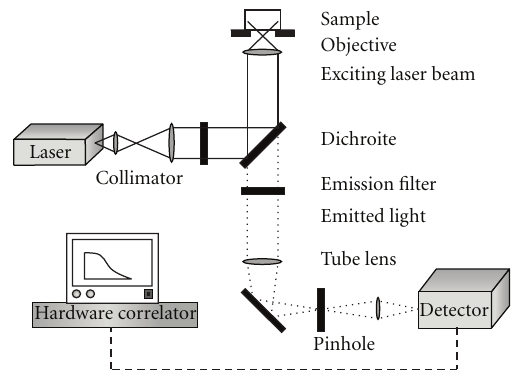
Figure 1: Experimental setup for fluorescence correlation spec-